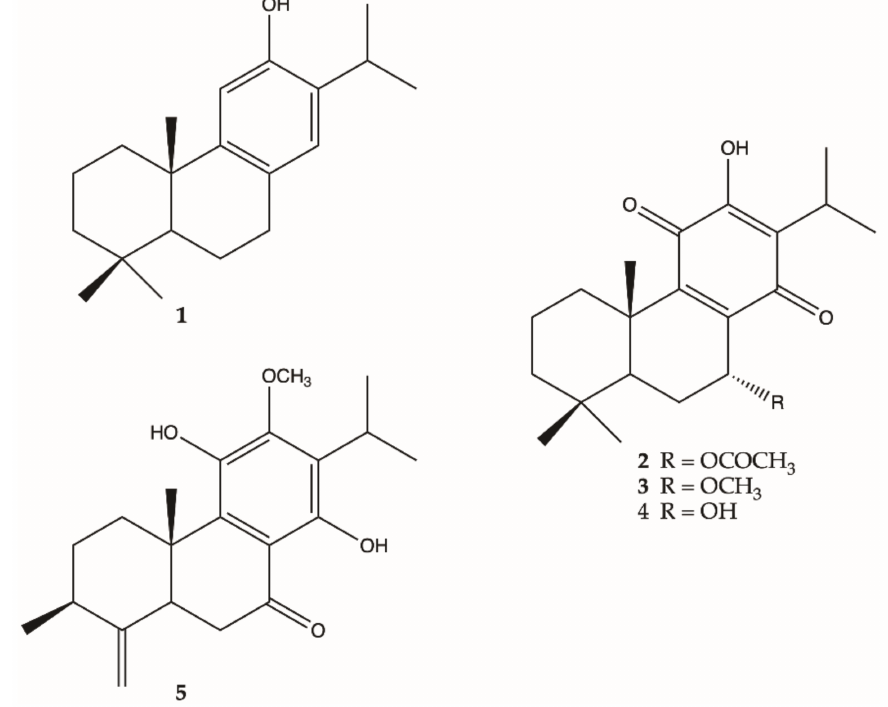
Figure 3. Chemical structures of abietane diterpenes isolated from the untransformed roots and hairy root of. S. corrugata